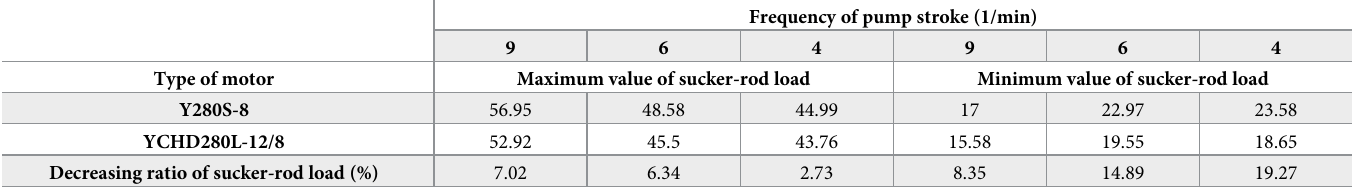
Table 6. Comparison of suspended point